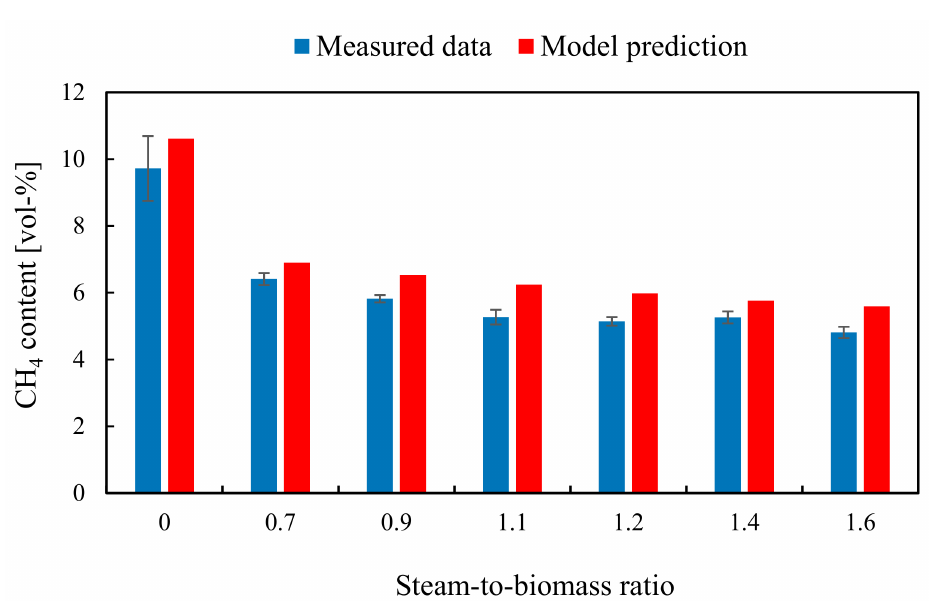
Figure 10. Effect of SBR on methane